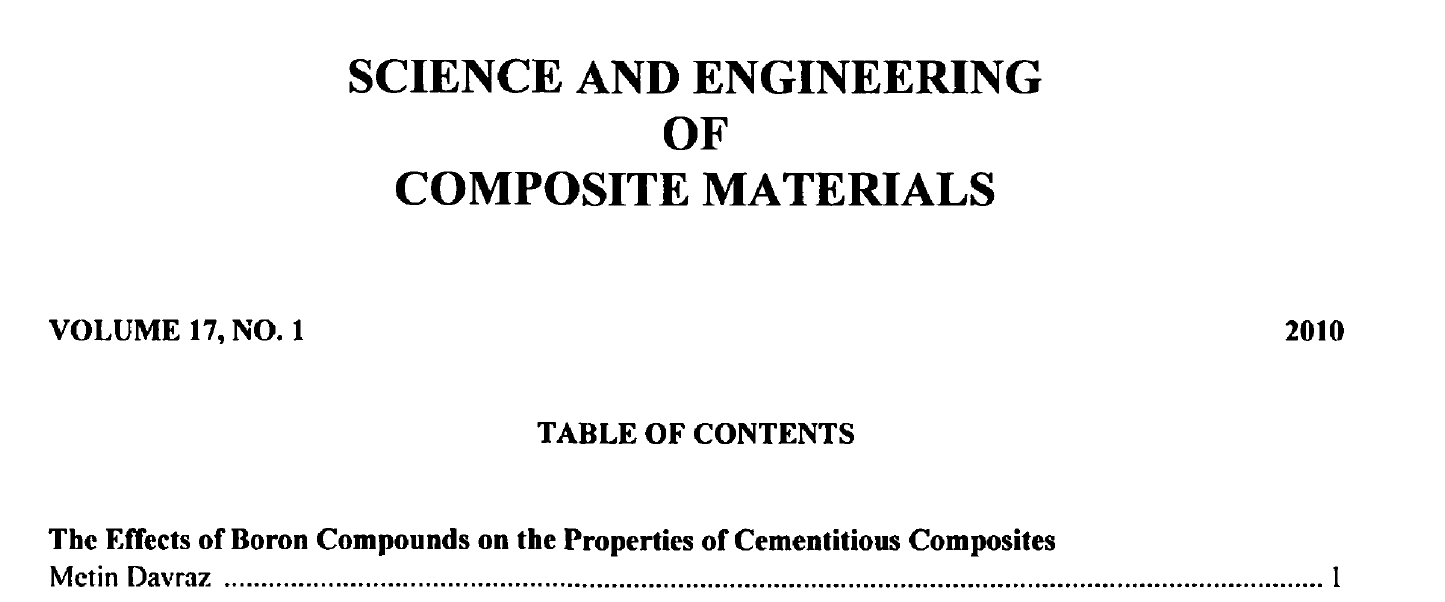
The Influence of Clay Dispersion, Clay Concentration and Epoxy Chemistry on the Fracture Toughness of Epoxy Nacocomposites